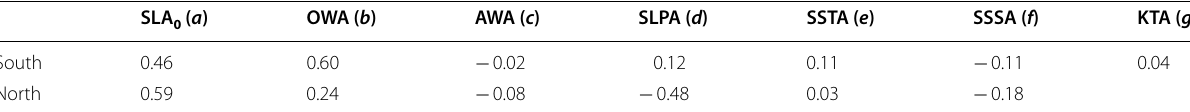
, OWA, AWA, SLPA, SSTA, SSSA and KTA after 1-year low 0